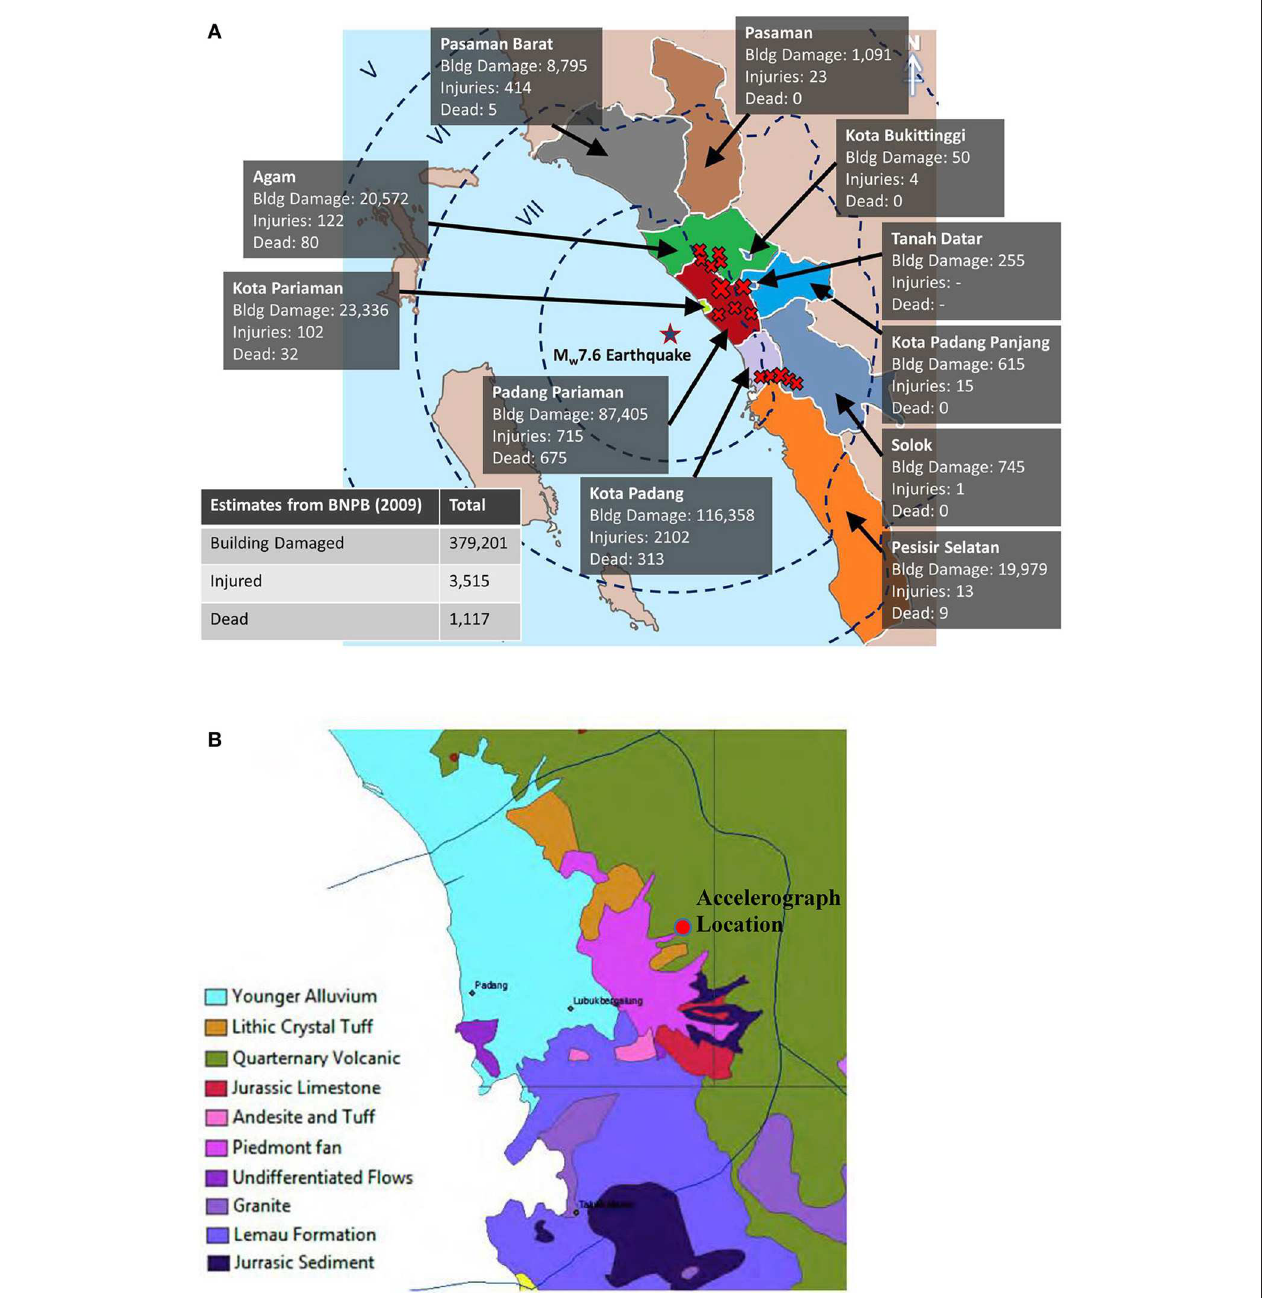
FIGURE 1 | Location and geological map of Padang. (A) Distribution of losses and MMI scale felt in the district of Padang [after Badan Nasional Penanggulangan Bencana (BNPB), 2009; United States Geological Survey (USGS), 2010a]. (B) Geological map of Padang (ESDM, 2009).